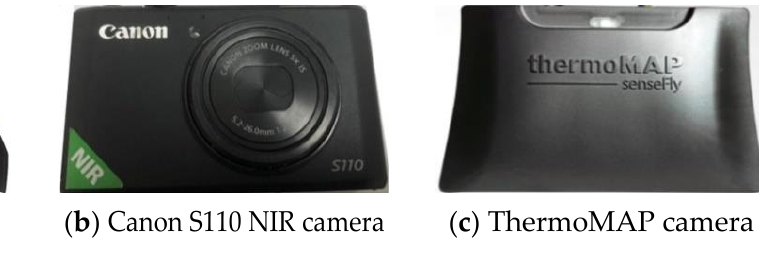
Figure 3. The UAV system. Figure 3. The UAV Table 1. Specifications of Canon S110 NIR camera.